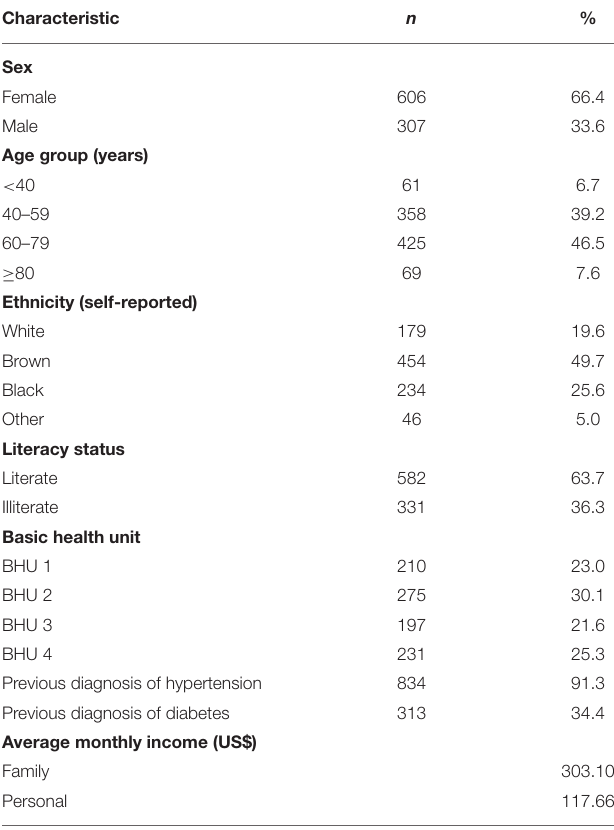
TABLE 1 | Main characteristics of the participants who visited the health fairs and patient